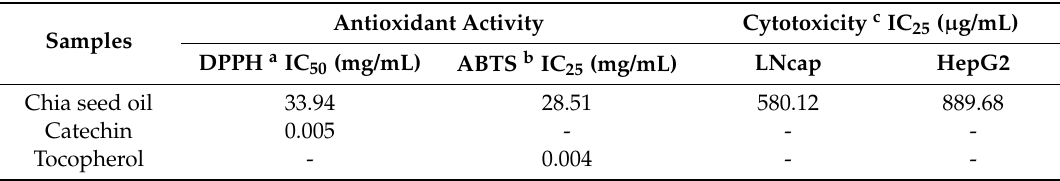
Table 4. Antioxidant activity and cytotoxicity of chia seed